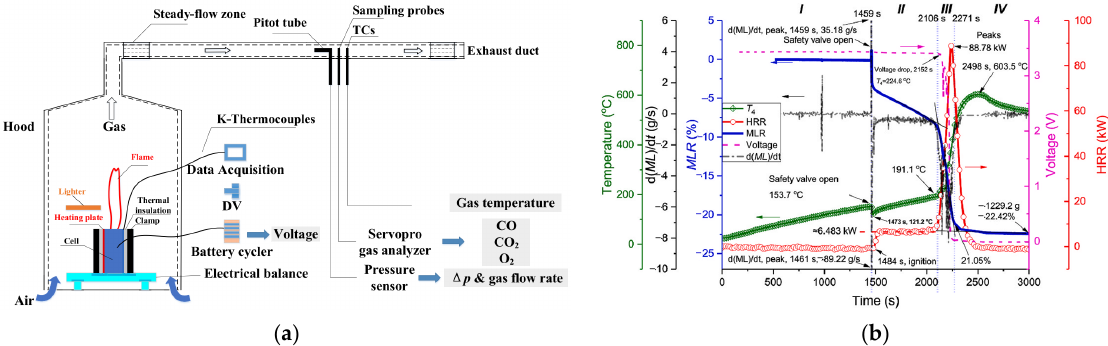
Figure 15. Active safety protection technology of LIB: ( a ) Thermal runaway experimental test setup for large-scale LFP battery; ( b ) stage division of thermal runaway process [110].